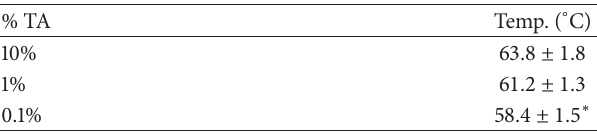
Table 1: Results of denaturation studies. % TA Temp. ( ∘ C) 10% 63.8 ± 1.8 1% 61.2 ± 1.3 0.1% 58.4 ± 1.5